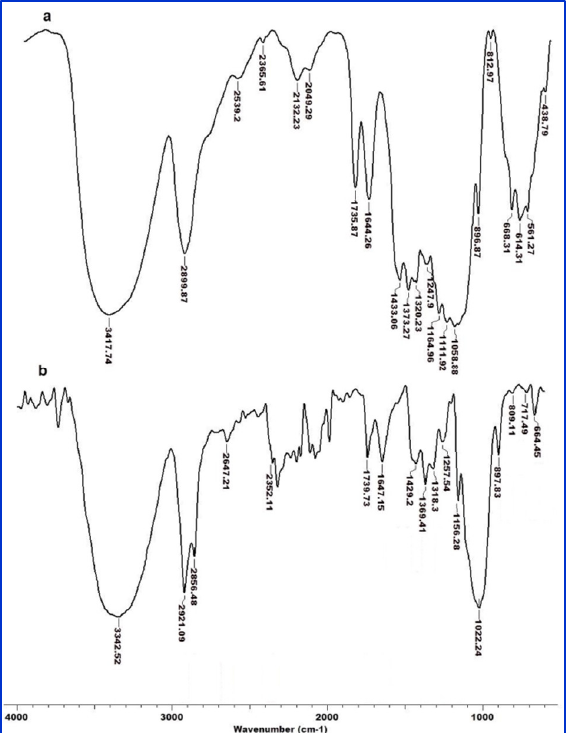
Figure 6. FTIR spectra of wood cellulose from hardwood species—beech tree: initial ( a ), and regen- erated from ionic liquid solution ( b ).